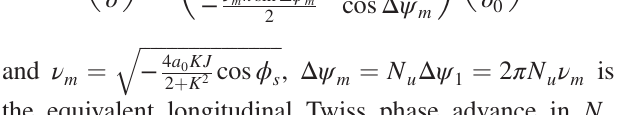
FIG. 10. Longitudinal Twiss function inside a laser modulator at different synchrotron phases. Left: ϕ s ¼ π and a 0 ¼ 4 × 10 − 4 , Twiss function oscillates. Right: ϕ s ¼ 0 and a 0 ¼ 4 × 10 − 5 , Twiss function diverges.